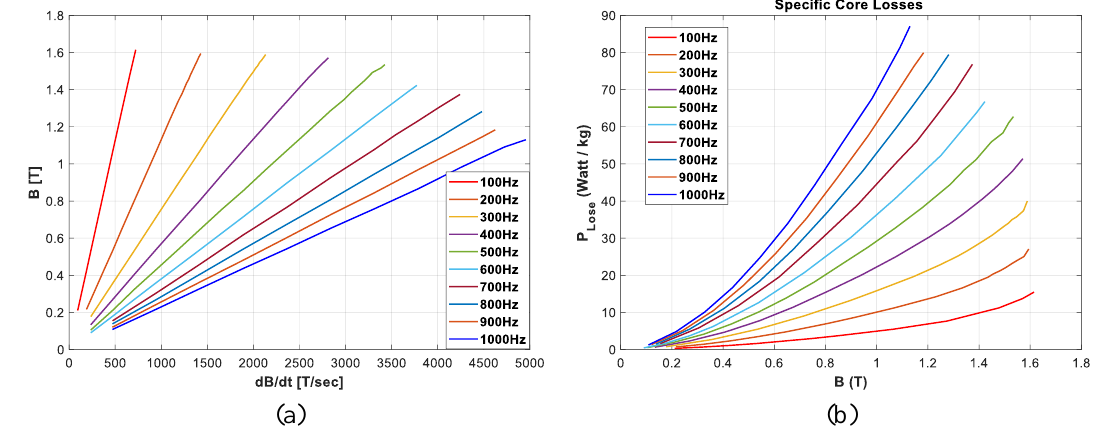
Figure 14. Comparison between complete core performance at different frequencies. ( a ) dB/dt. ( b ) Specific core losses.